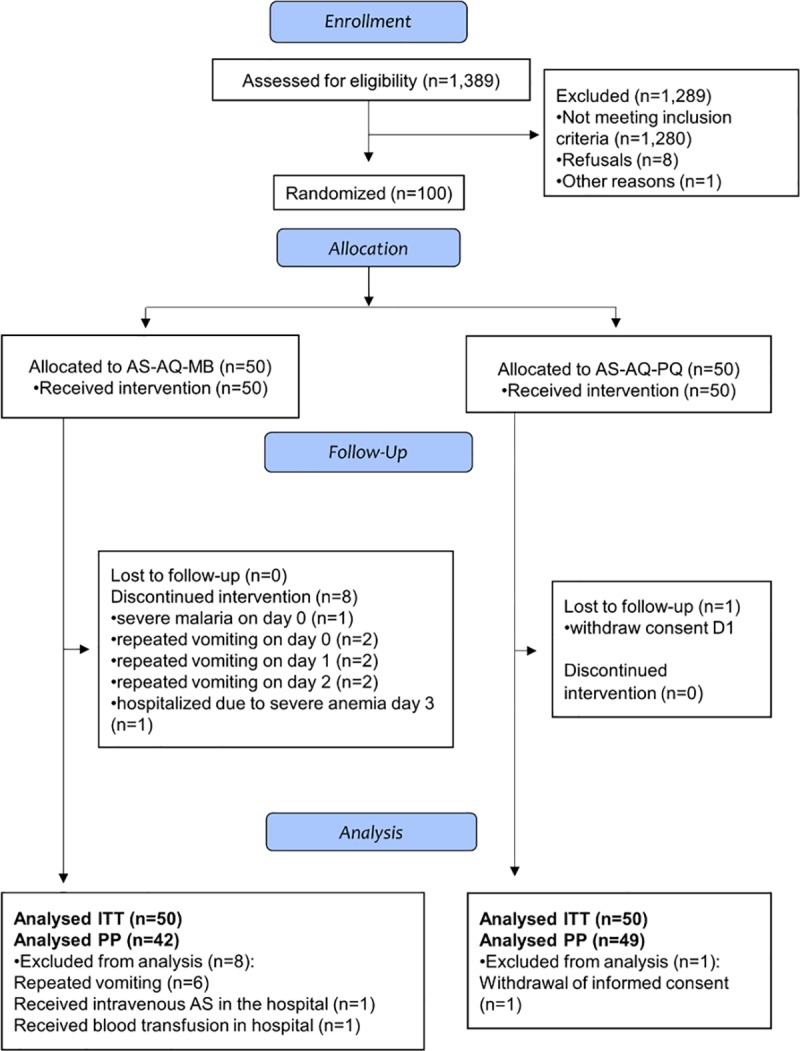
Consort flow chart.